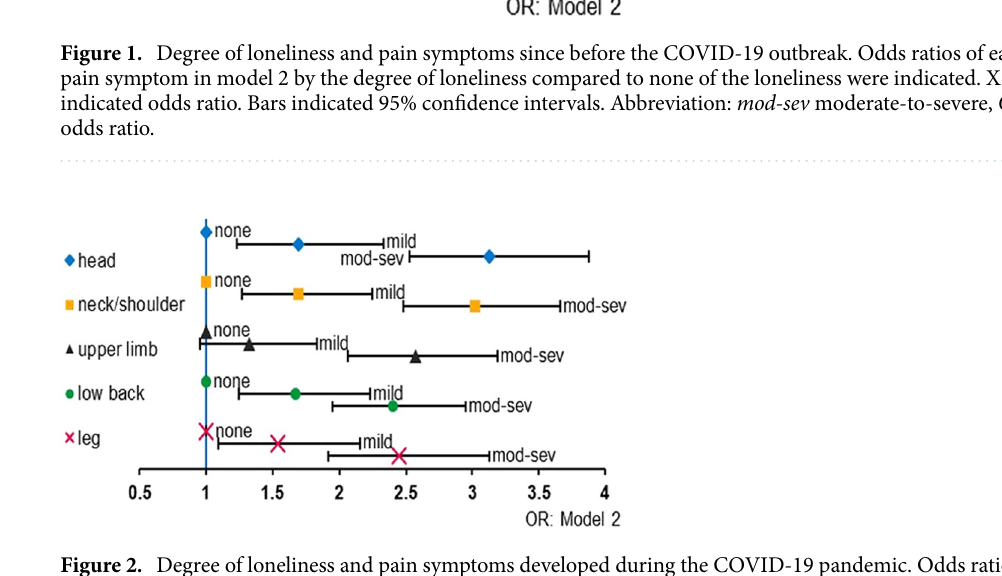
Figure 2. Degree of loneliness and pain symptoms developed during the COVID-19 pandemic. Odds ratios of each pain symptom in model 2 by the degree of loneliness compared to none of the loneliness were indicated. X-axis indicated odds ratio. Bars indicated 95% confidence intervals. Abbreviations: mod‑sev moderate-to- severe, OR odds